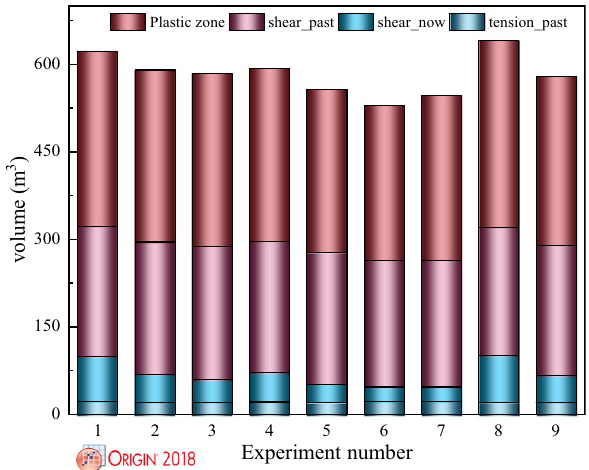
Figure 10. Volume variation law of plastic zone under different support schemes.